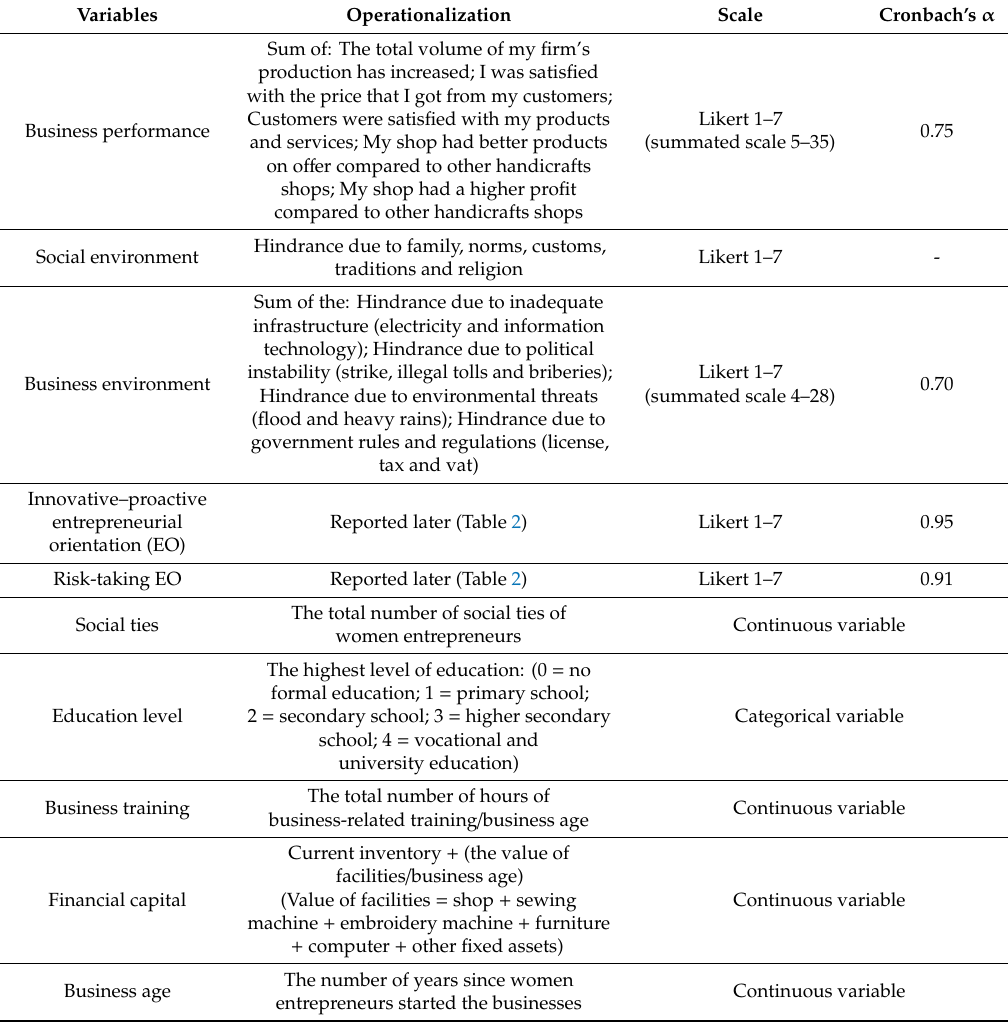
Table 1. Operationalization of variables.